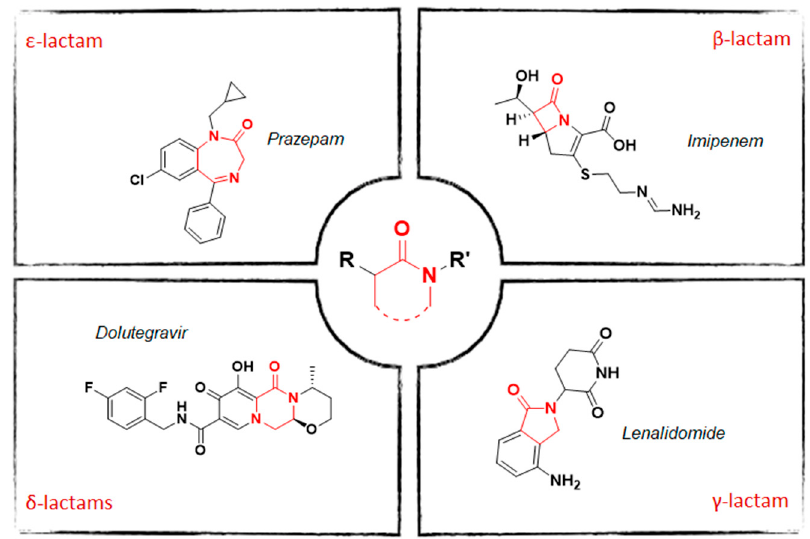
Figure 1. Examples of marketed drugs based on the lactam scaffold.